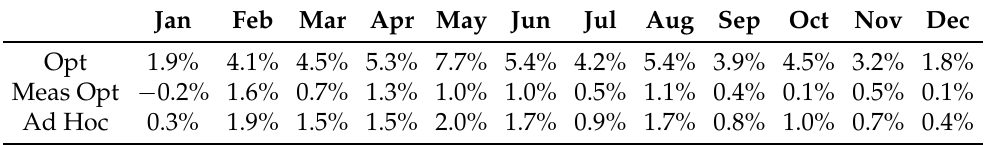
Table 13. Monthly PV self-consumption improvement for a building cluster with doubled storage